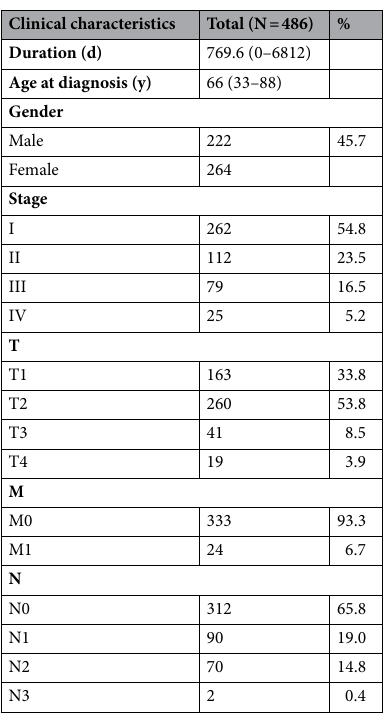
Table 1. Clinic-pathological features of LUAD patients in